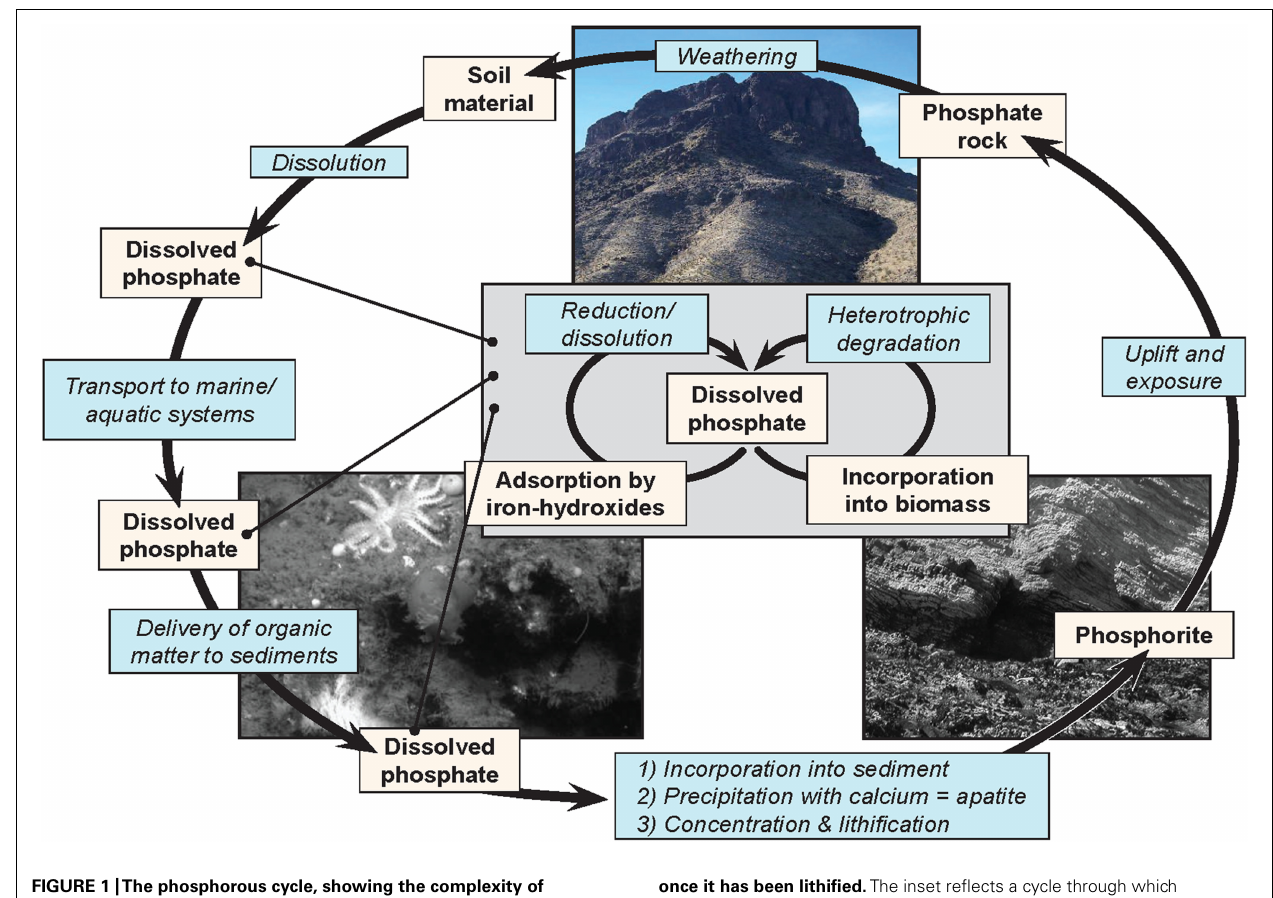
FIGURE 1 |The phosphorous cycle, showing the complexity of phosphorus cycling, and the relative inaccessibility of phosphorus